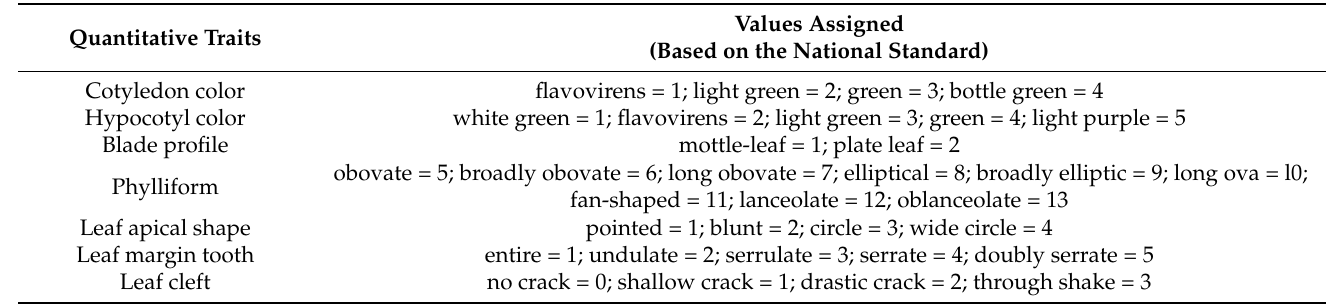
Table 3. The national standard for assigning a value for quantitative